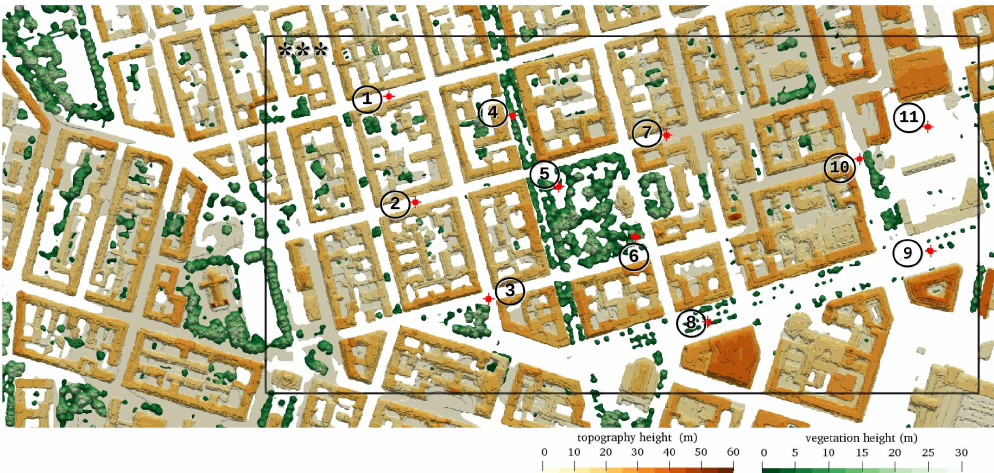
Figure 5. Locations of the flow data extraction sites (indicated by red dots next to circled identification number 1-11 ) within the Ω ( 3 ) domain: In this document, the data sites are denoted by M1 , M2 , ... , M11 . At each location, vertical profiles of prognostic variables are gathered at frequency f = 80/ T